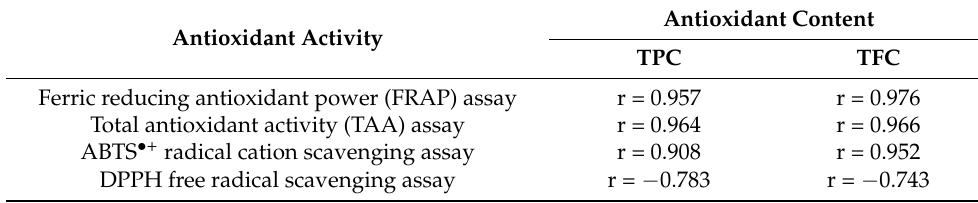
Antioxidant Content TPC TFC